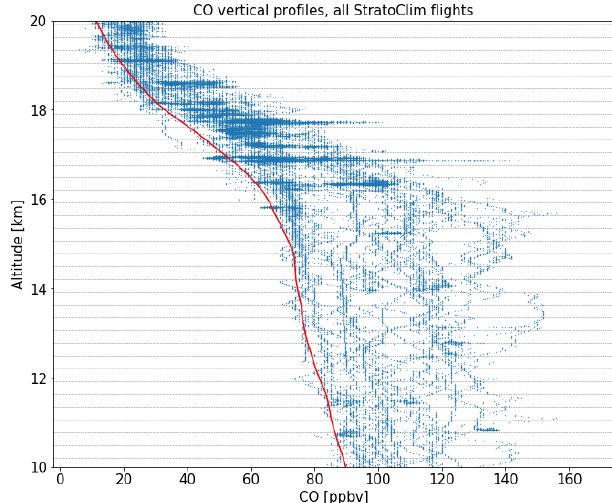
Figure 2. Total CO measurements along all eight flights of the cam- paign. The red line represents the estimated CO background, com- puted as the fifth percentile of the measurements along the 240m altitude bins (horizontal thin grey lines).